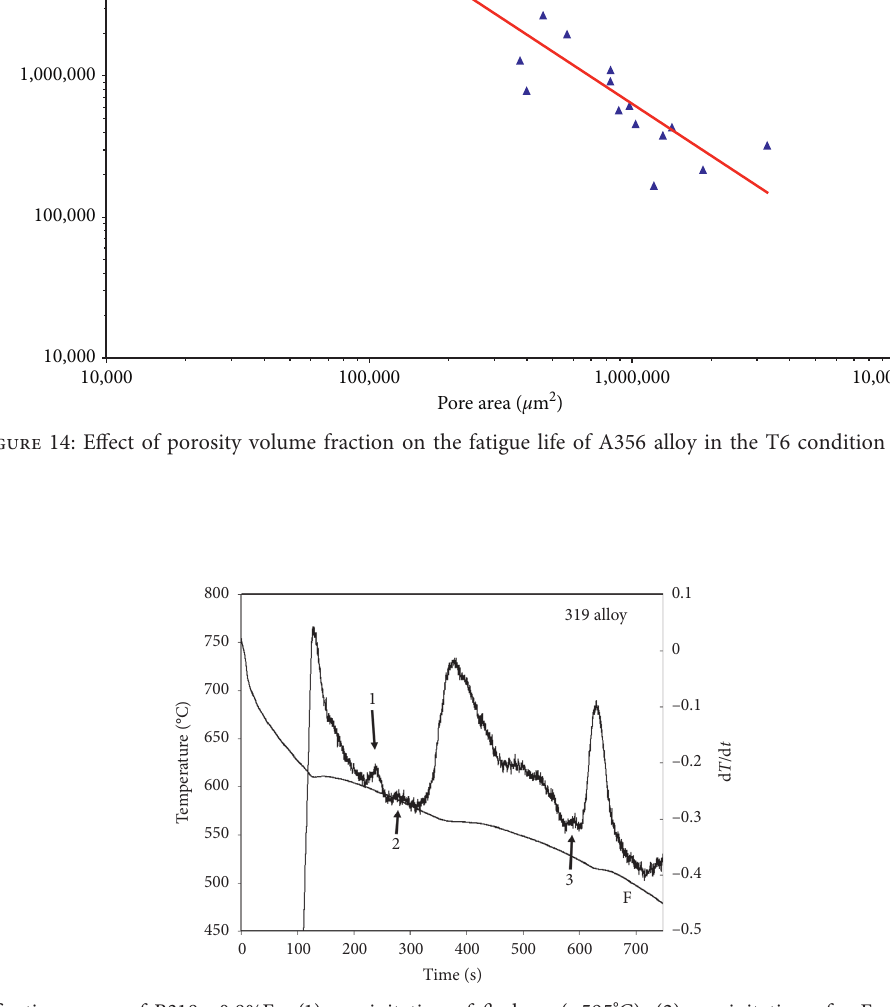
Figure 15: Solidification curve of B318+0.8%Fe: (1) precipitation of β -phase ( ∼ 595 ° C), (2) precipitation of α -Fe ( ∼ 580 ° C), (3) partial transformation of β -Fe to π -Fe (540 °